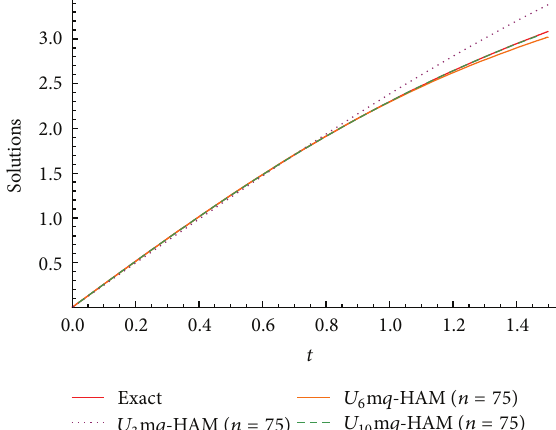
Figure 7: The comparison between the absolute error of 𝑈 3 , 𝑈 6 , and 𝑛 HAM (m 𝑞 -HAM; 𝑛 = 1) of (28) at ℎ = −1 , 𝑥 = 1 , and 𝑈 10 of 0 ≤ 𝑡 ≤ 1.5 .